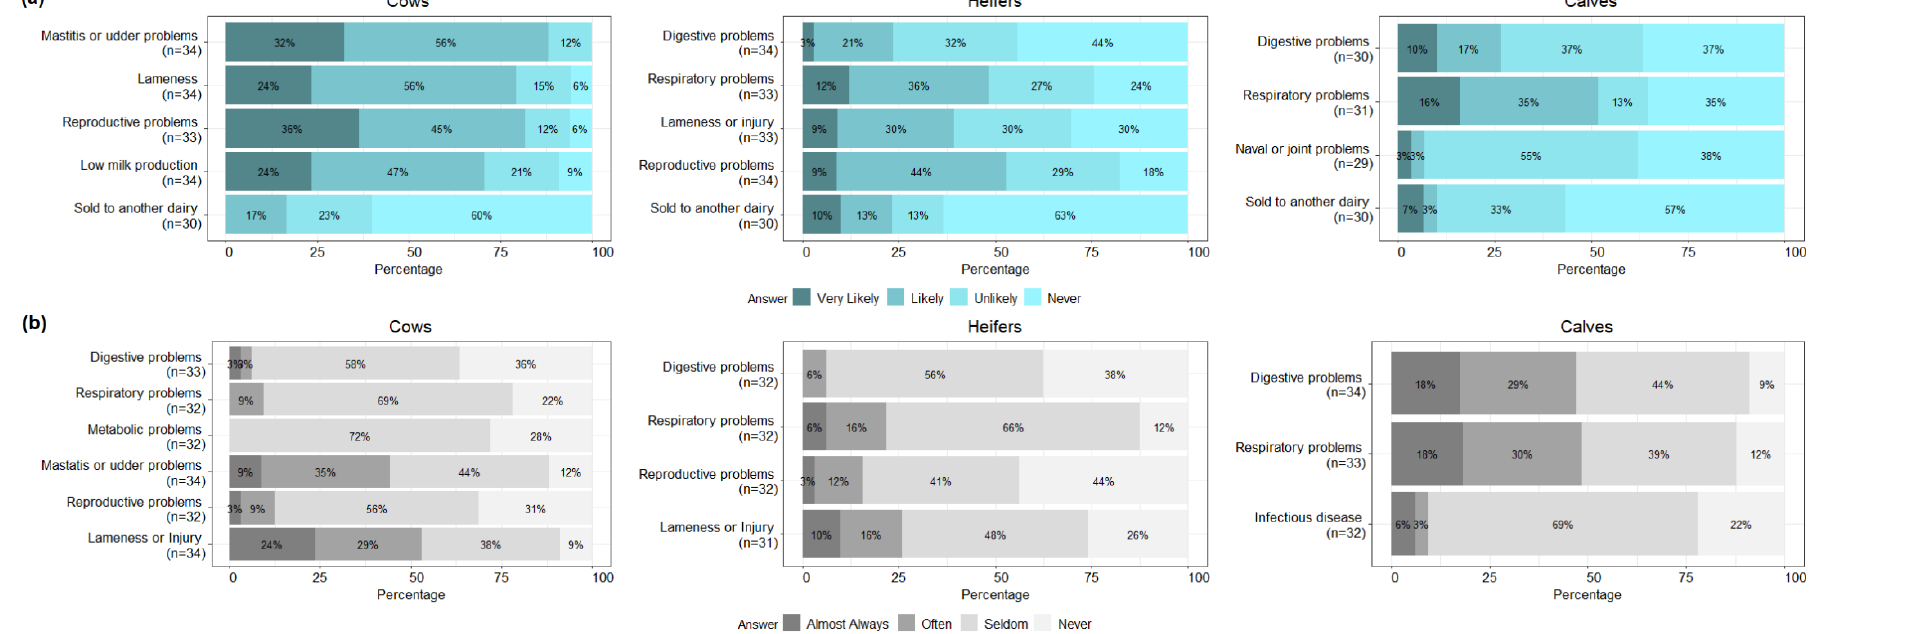
Figure 2. Reasons for permanent removal/culling ( a ) and for death/euthanasia ( b ) of dairy animals during the last 12 months by age class reported by farmers (n = 36 farms surveyed).